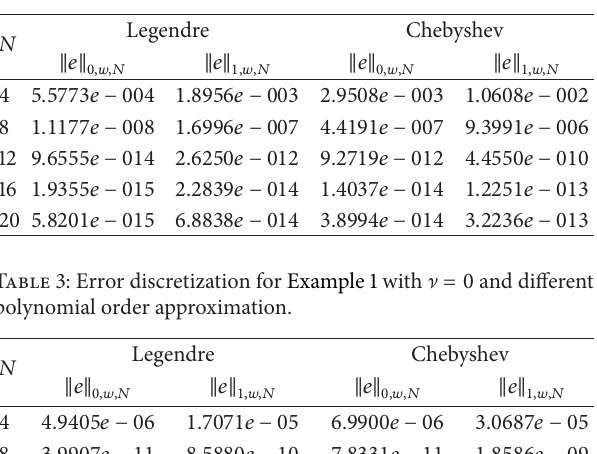
Table 2: Error discretization for Example 1 with ] = 10 .